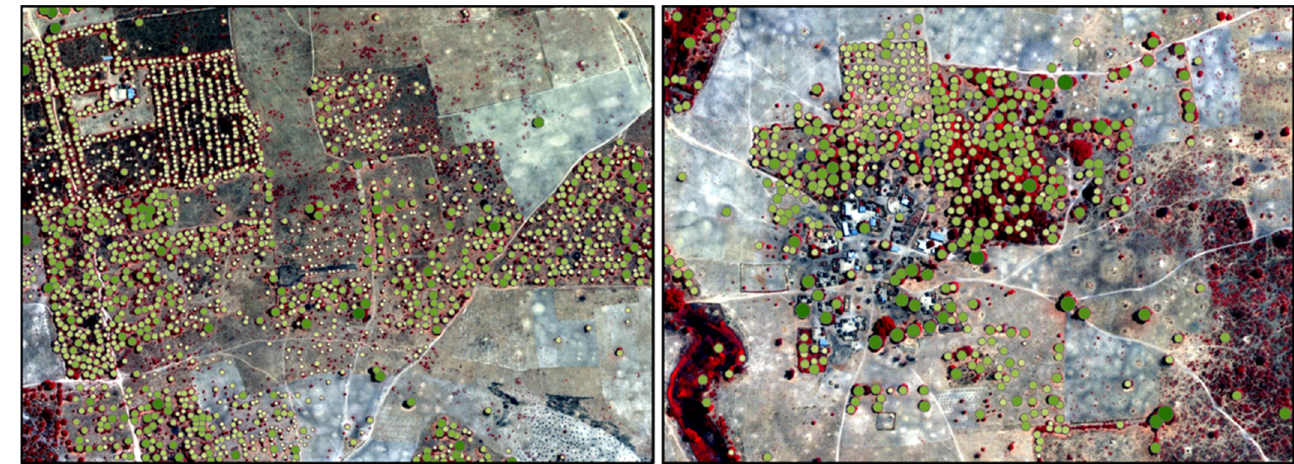
Figure 7. Examples of VHR remote sensing tree carbon mapping product. The area of the crown is mapped by the size of the polygons and carbon stock per tree is colored in a green shade, where darker color indicates higher carbon.